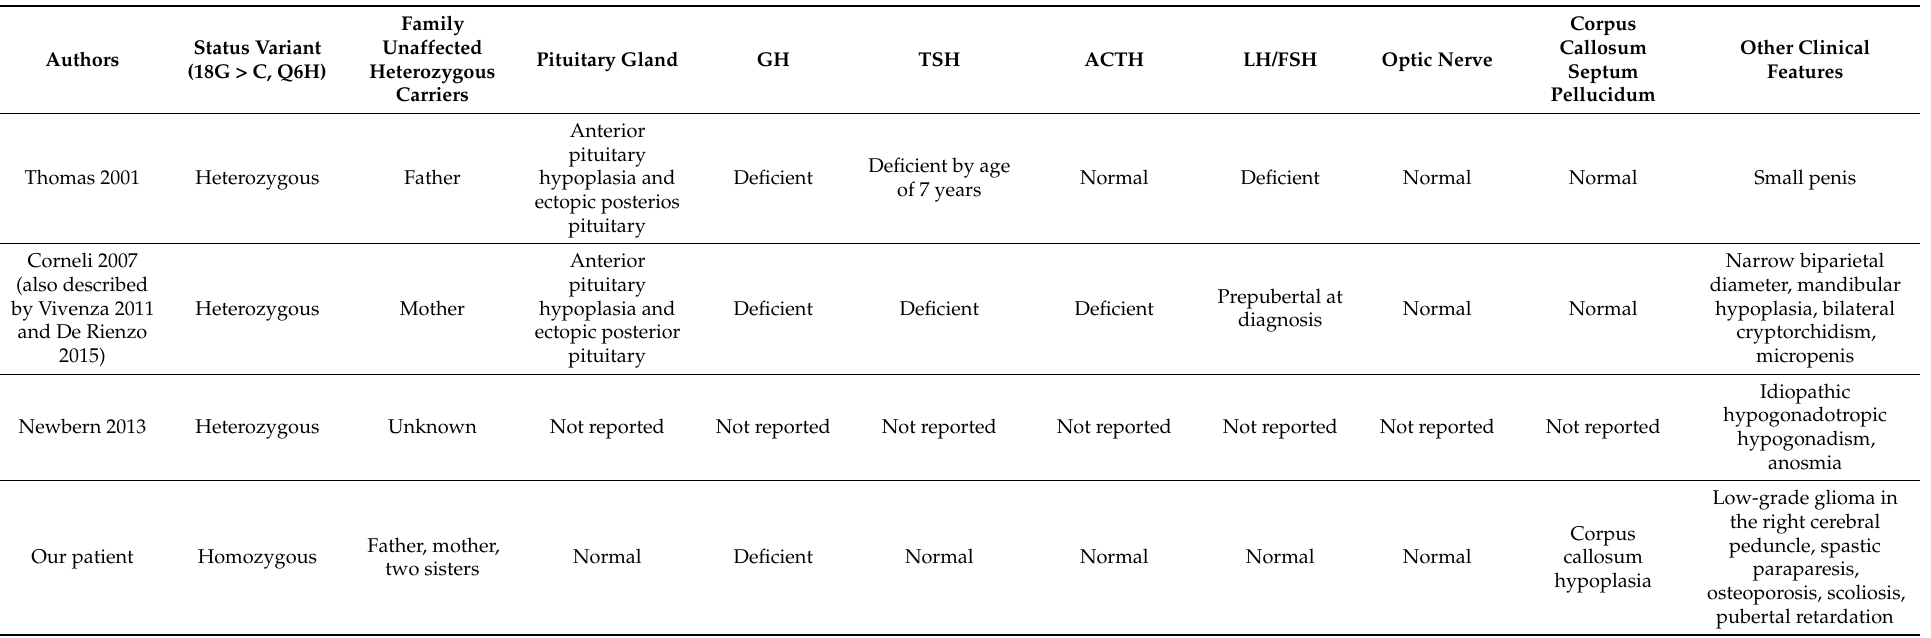
Table 1. Clinical details of patients harboring 18G > C variant in